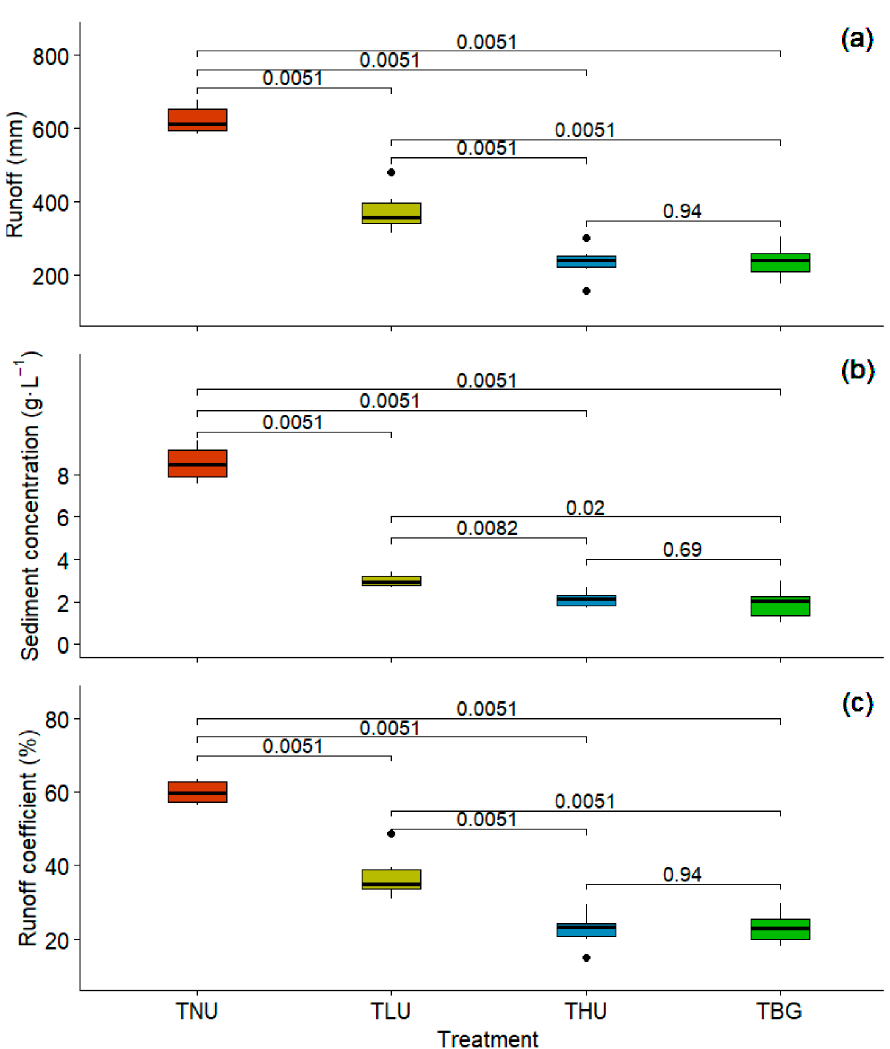
Figure 7. Boxplots of ( a ) cumulative surface runoff (mm), ( b ) average suspended sediment concentration (g·L − 1 ), and ( c ) runoff coefficient (%) in each treatment measured from 4 June to 15 October 2017, in Ban Kokngew, Luang Prabang Province, Lao People’s Democratic Republic. Each rainfall bar represents the accumulated rainfall over the period prior to the sampling. Each boxplot contains the extreme of the lower whisker (vertical line), the lower hinge (thin line), the median (bold line), the upper hinge (thin line), the extreme of the upper whisker (vertical line), and the outliers (black dots) with p -values from Wilcoxon tests between two groups of treatments. The whiskers extend to the most extreme data point, which is no more than 1.5-times the interquartile range from the box. TNU: teak with no understory; TLU: teak with low density of understory; THU: teak with high density of understory; TBG: teak with broom grass. The runoff coefficient is the ratio in percentage between total surface runoff depth and total rainfall depth.